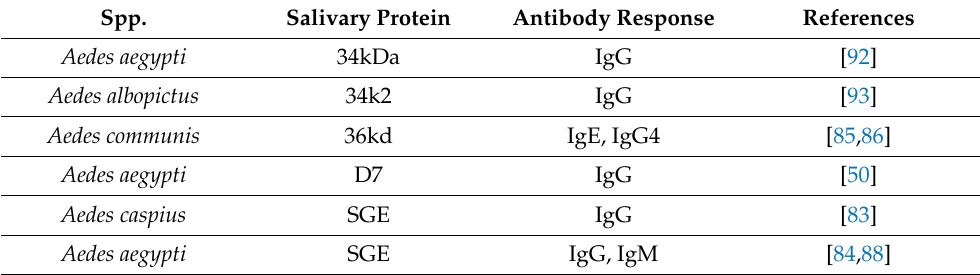
Table 4. Natural antibody responses against arthropod salivary proteins. Spp. Salivary Protein Antibody